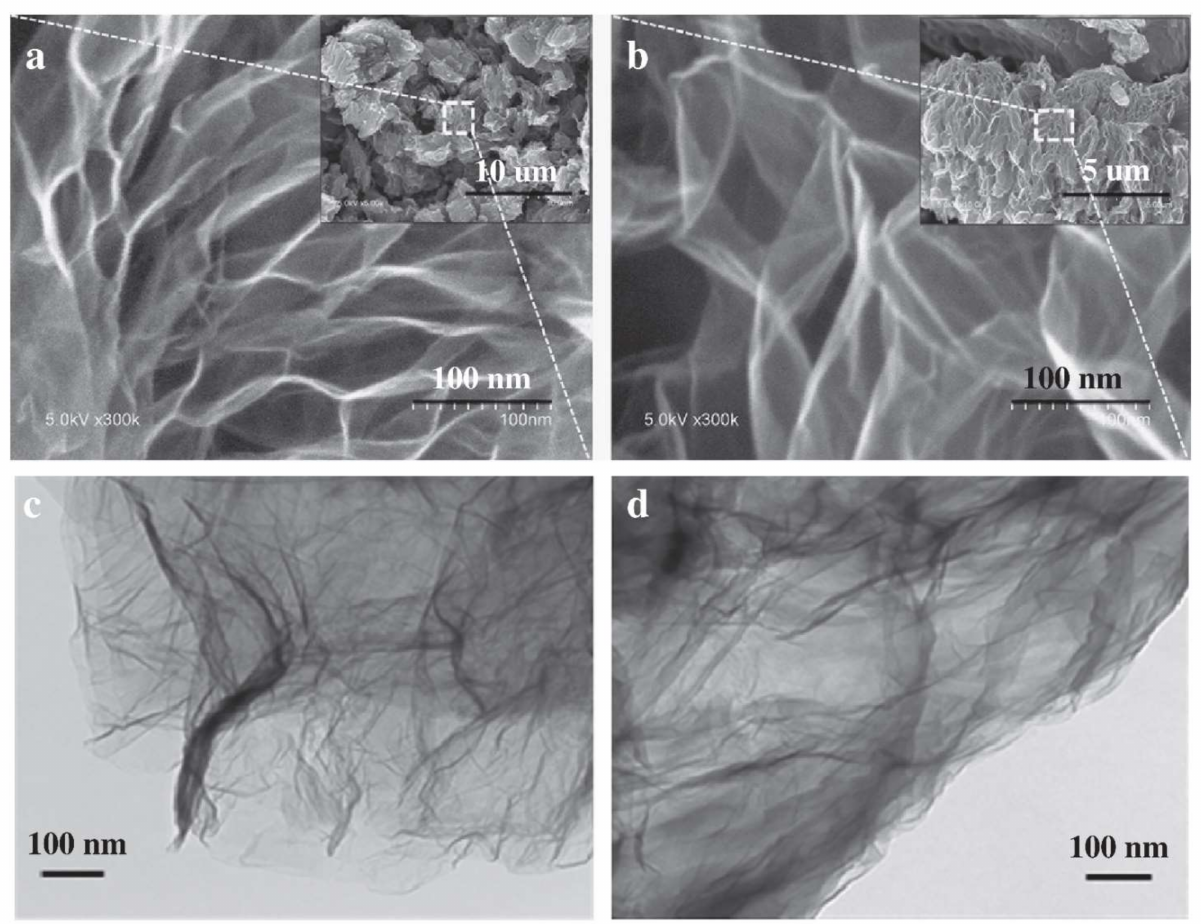
Figure 11. Electron micrographs of GNS and N-GNS; SEM images ( a ) GNS and ( b ) N-GNS; TEM ( c ) GNS and ( d ) N-GNS. Adapted and reproduced with permission from Ref. [39]. Copyright 2011